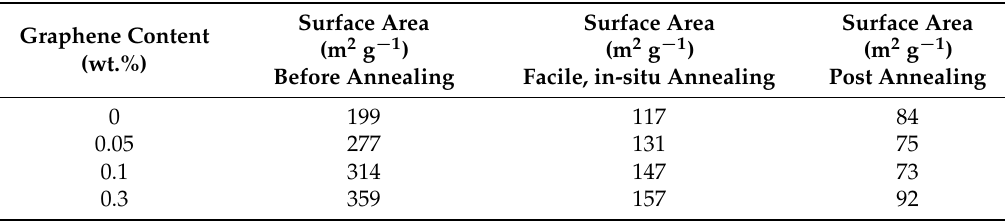
Table 2. Comparison of the effect of in situ annealing on the specific surface area of SnO 2 aerogel, with and without the addition of graphene